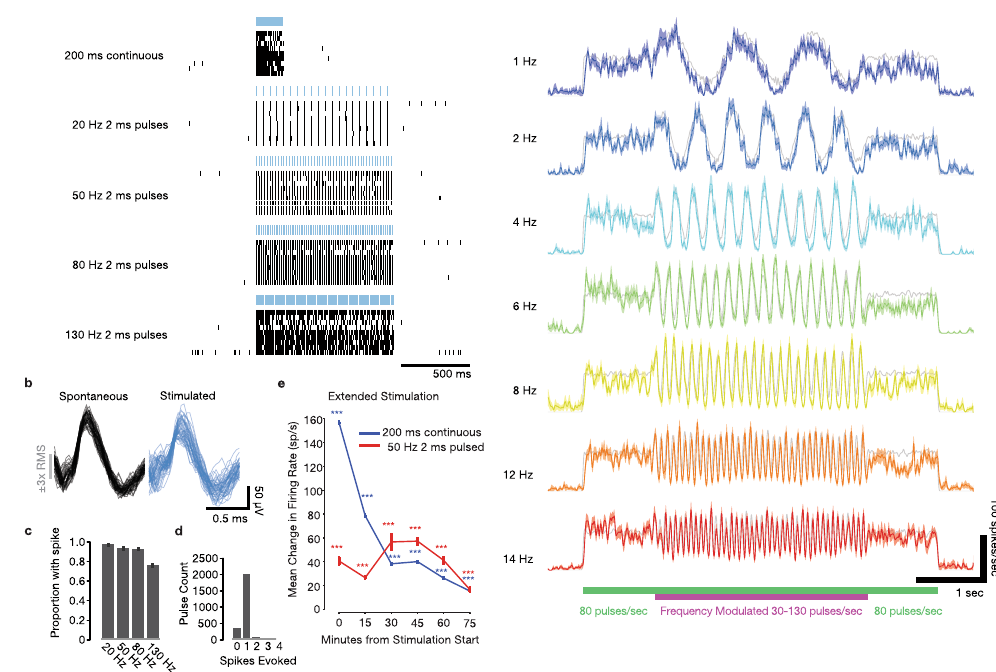
Figure 5. In vivo optogenetic stimulation and electrophysiology facilitates verification of optogenetic modulation in an anesthetized squirrel monkey. ( a ) Spike response raster during pulsed and continuous stimulation with 473 nm light of an example recorded single-unit recorded in a Sq. P with AAV5-hSyn- ChR2(H134R) in left M1. ( b ) Spontaneous and light-evoked spike waveforms. ( c ) Proportion of light pulses which evoked at least one spike in this unit vs. pulse frequency. Error bars show 95% confidence intervals for success probability (Clopper-Pearson method). ( d ) Histogram of spike counts evoked per light pulse. ( e ) Optogenetic response to extended stimulation over 90 minute stimulation session. Change in firing rate (stimulation minus per-trial pre-stimulation baseline) of recorded multiunit activity evoked by optical stimulation with 200 ms continuous pulses delivered at 1 Hz (in Sq. E left M1), or 50 Hz 2 ms pulse trains delivered for 5 sec interspersed with 10 sec off periods (in Sq. T, left M1). Error bars show ± SEM. “ *** ” indicates significant elevation of firing rates by stimulation during the corresponding 15 minute epoch ( p < 0.001, two-sided sign-rank test). ( f ) Light-evoked firing rate responses of an example AAV5-CamKII α - C1V1-transfected neuron recorded in Sq. U left PMd, during frequency-modulated pulsed stimulation with 561 nm light. Gray lines indicate the idealized average firing rate that would be evoked if the unit spiked exactly once per light pulse. Color shading indicates ± SEM. See